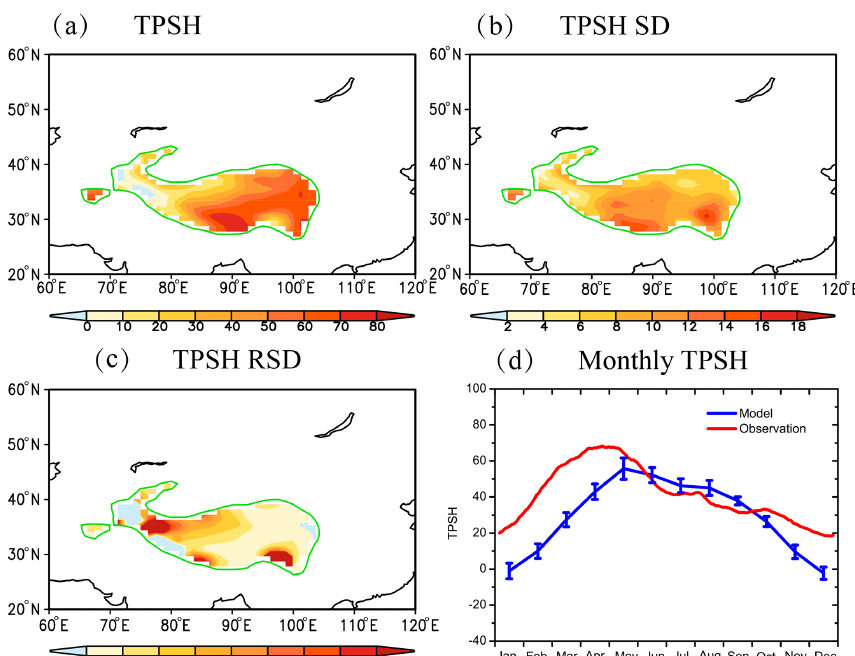
Figure 1. Spatial distribution of (a) the MAM mean sensible heat over the TP (TPSH, Wm − 2 ), (b) the standard deviation of TPSH (SD, Wm − 2 ), and (c) the relative SD of TPSH (RSD, %) in MAM calculated for 30 model years. (d) Annual cycle of TPSH from the model averaged over the TP region above 2500m and the observations averaged over the 73 stations over the TP (Duan et al., 2017). Note that the error bars (d) represent the SD of the simulated TPSH for 30 model years. The green-contour area indicates the plateau above